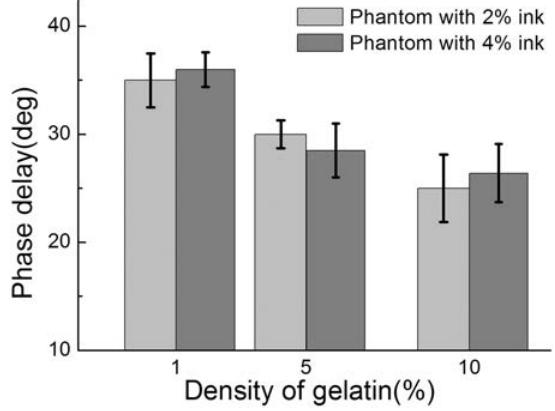
Fig. 2. Phase delay obtained by PAVEI from gelatin with di®erent absorption coe±cients.